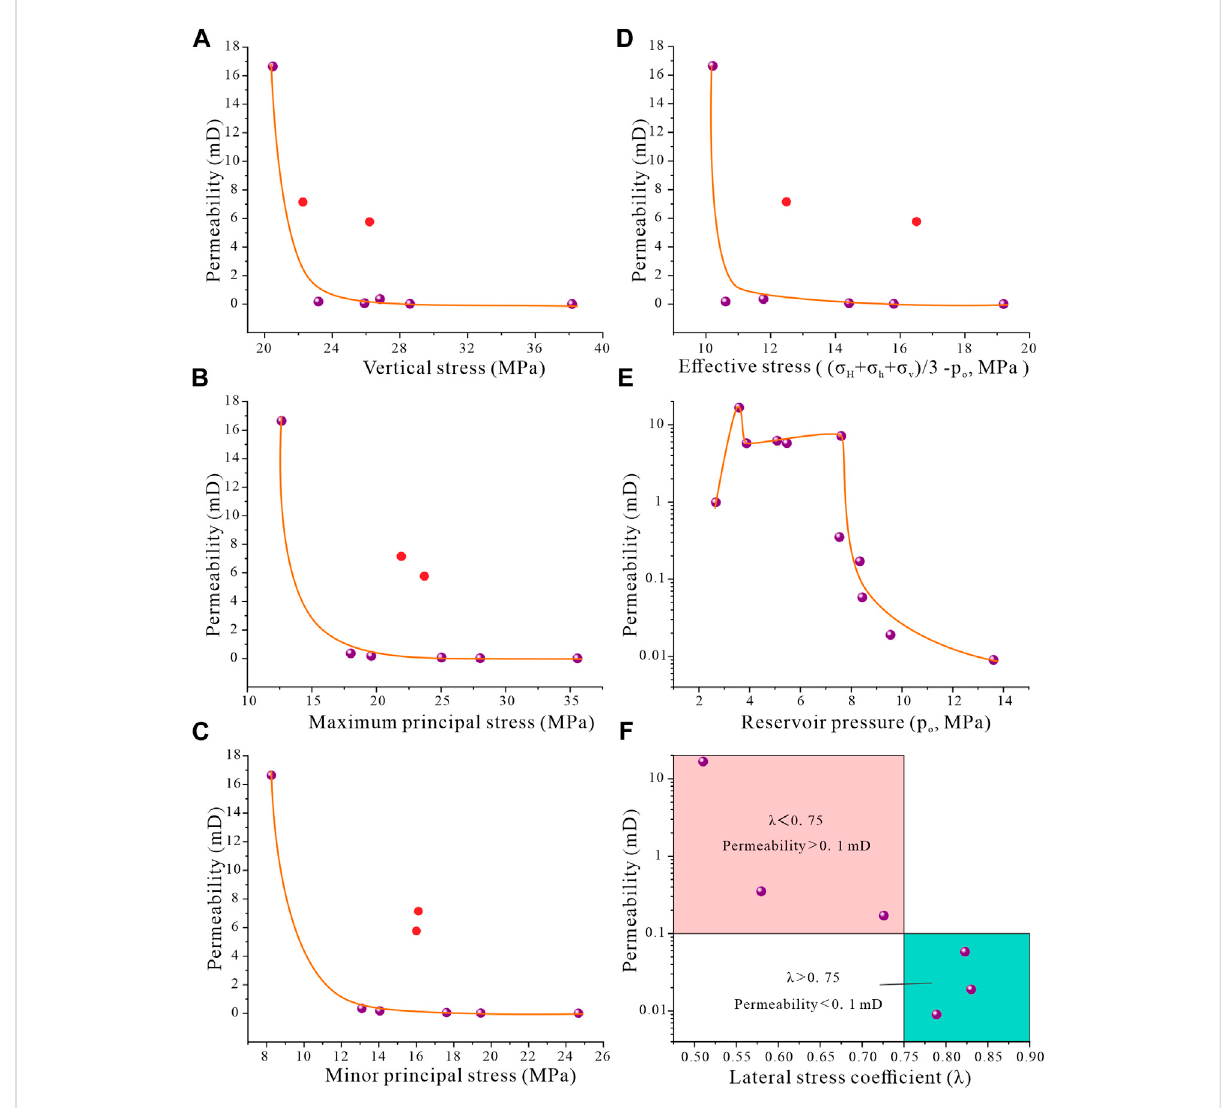
FIGURE 13 Diagram showing in fl uences of in-situ stress fi eld (A – C) , effective stress (D) , reservoir pressure (E) , and lateral stress coef fi cient (F) on permeability.